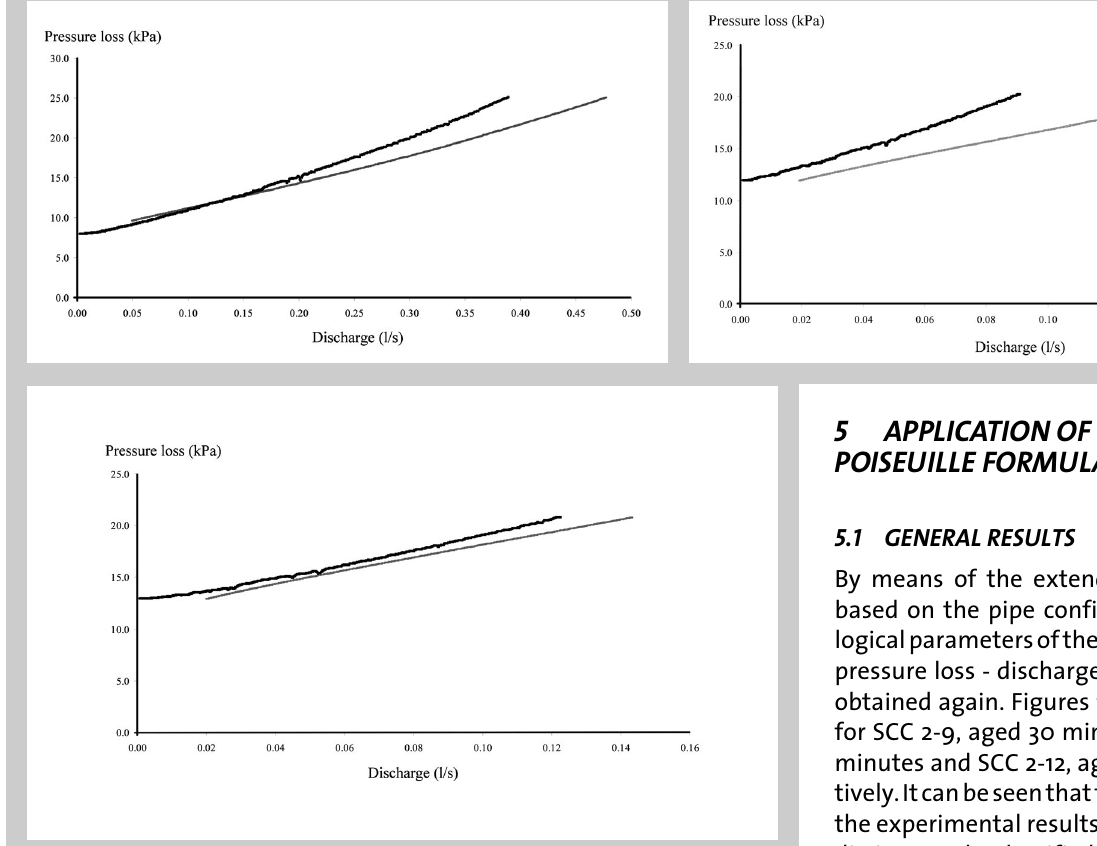
Figure 10 (left above): Comparison of measured flow-test results (black dots) and the calculations with Eq. 5 (grey line) for SCC 2-9, aged 30 minutes. Figure 11 (right above): Comparison of measured flow-test results (black dots) and the calculations with Eq. 5 (grey line) for SCC 1-12, aged 60 minutes. Figure 12 (below): Comparison of measured flow-test results (black dots) and the calculation with Eq. 5 (grey line) for SCC 2-12, aged 90